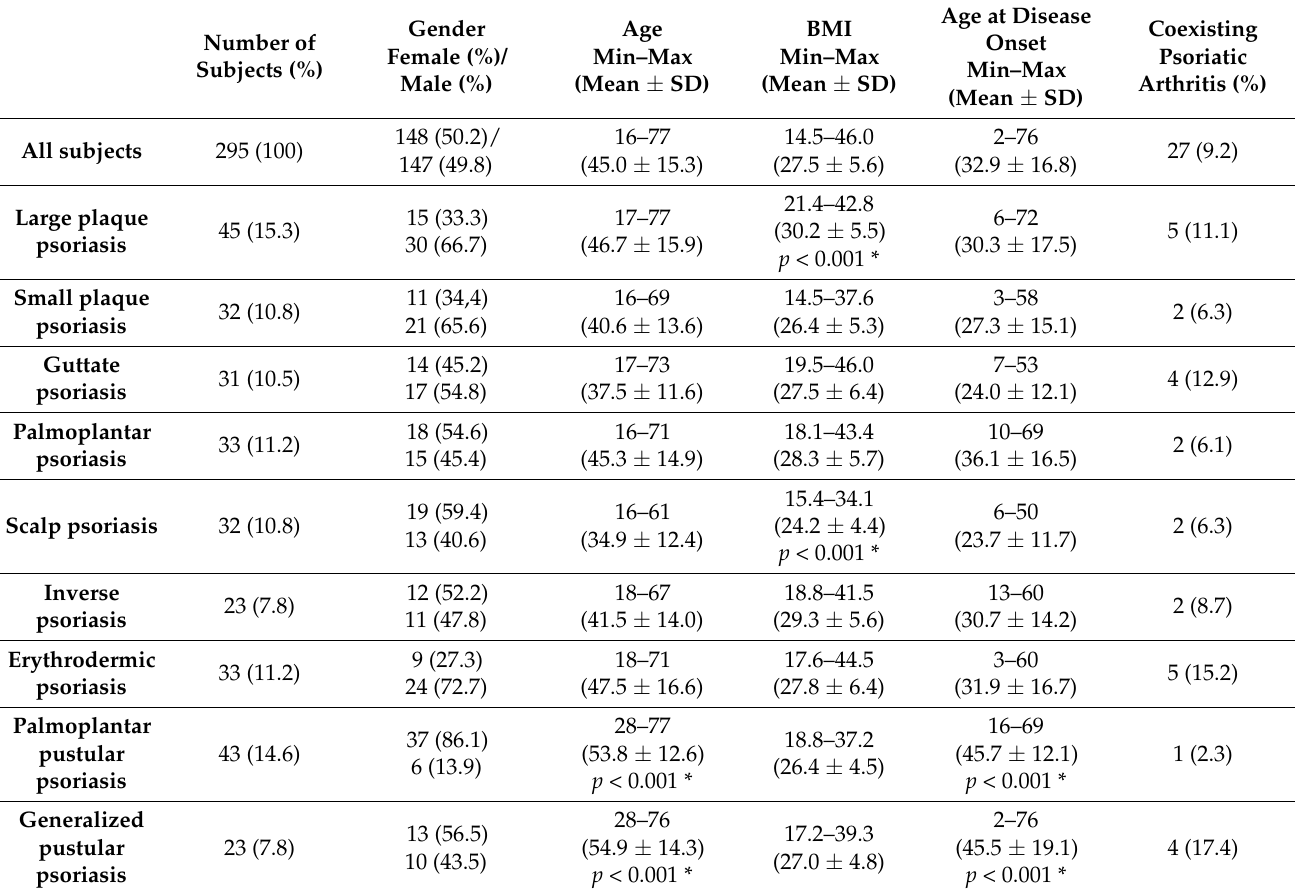
Table 1. Comparison of demographic, anthropometric and clinical data in patients with various clinical subtypes of psoriasis (statistically significant differences from other patients ( p < 0.05) were marked with